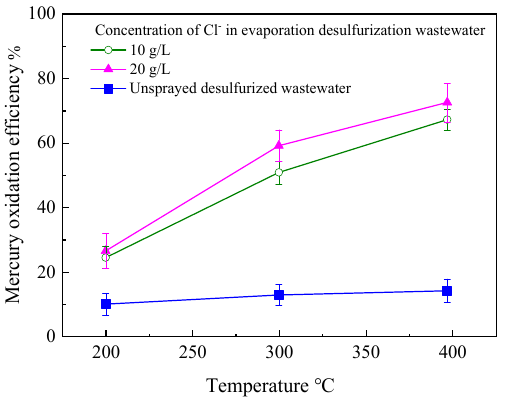
Figure 4. Oxidation efficiency of Hg 0 in the SCR device.